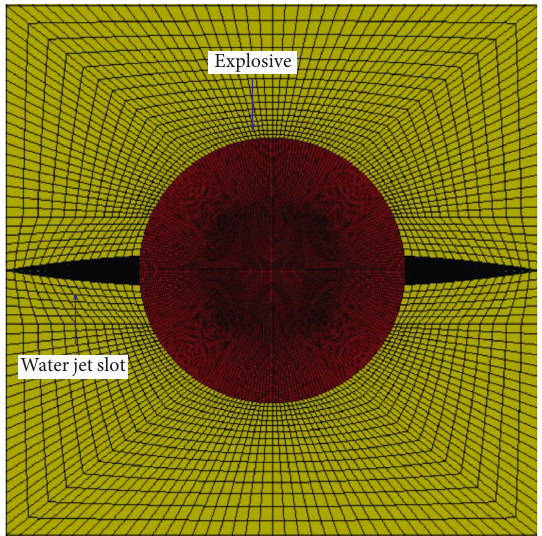
Figure 4: Local enlargement of